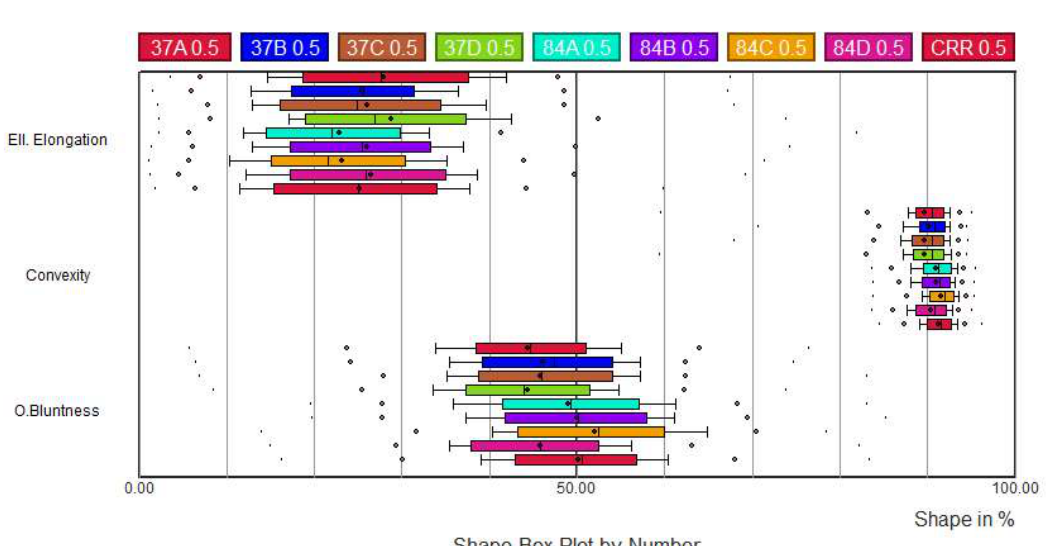
Figure A5. Shape analysis of particles (0.25–0.5 mm).